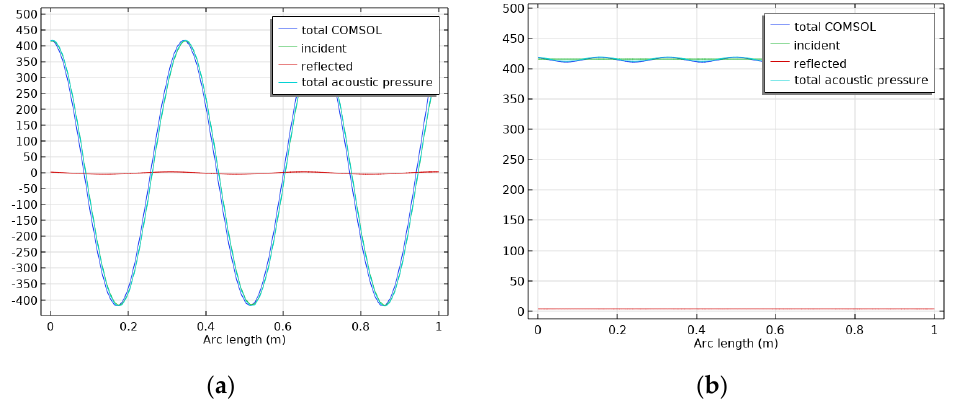
Figure 7. Updated model dimension: ( a ) real part of the pressure field in Pascal and ( b ) amplitude of the pressure field at f = 1000 Hz in Pascal.